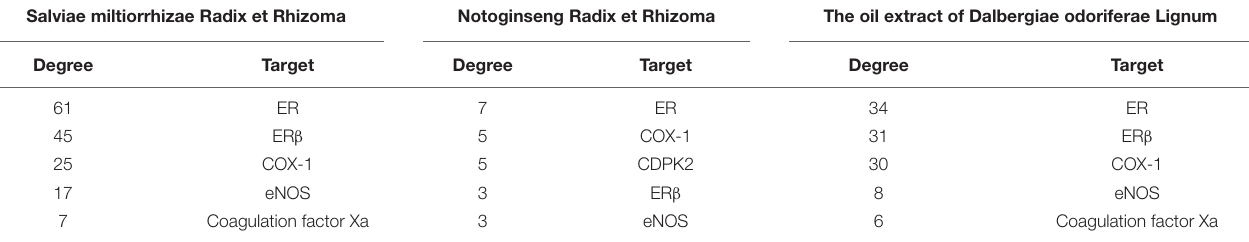
TABLE 1 | Target identification followed by degree-based screening of the three drugs in GXDSF. Salviae miltiorrhizae Radix et Rhizoma Notoginseng Radix et Rhizoma